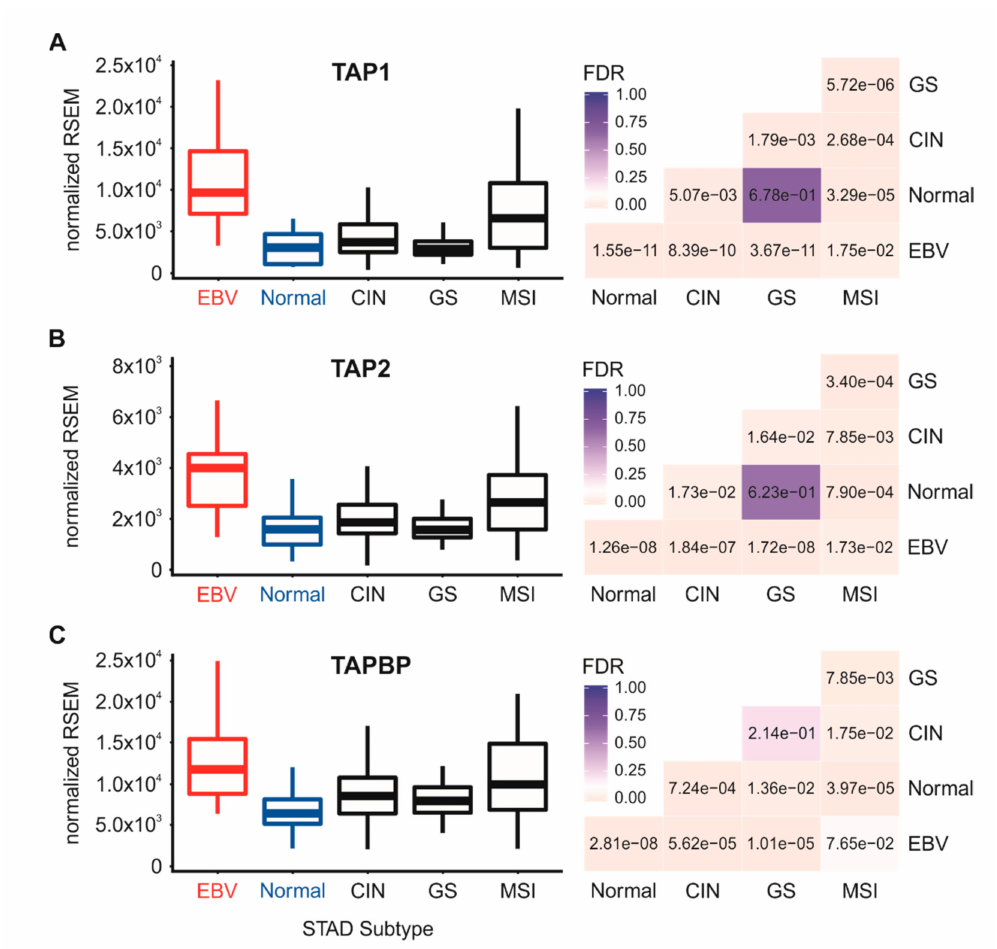
Figure 3. Expression levels of the TAP genes involved in MHC-I-dependent antigen presentation in gastric carcinoma subtypes and normal gastric tissue. Normalized RNA-seq data for the TAP1 ( A ), TAP2 ( B ) and TAPBP ( C ) genes involved in MHC-I-dependent antigen presentation were extracted from the TCGA database for the STAD cohort for EBVaGCs, normal control tissues, and three other GC subtypes. FDR-adjusted p -values for each statistical comparison are shown on the right for each gene